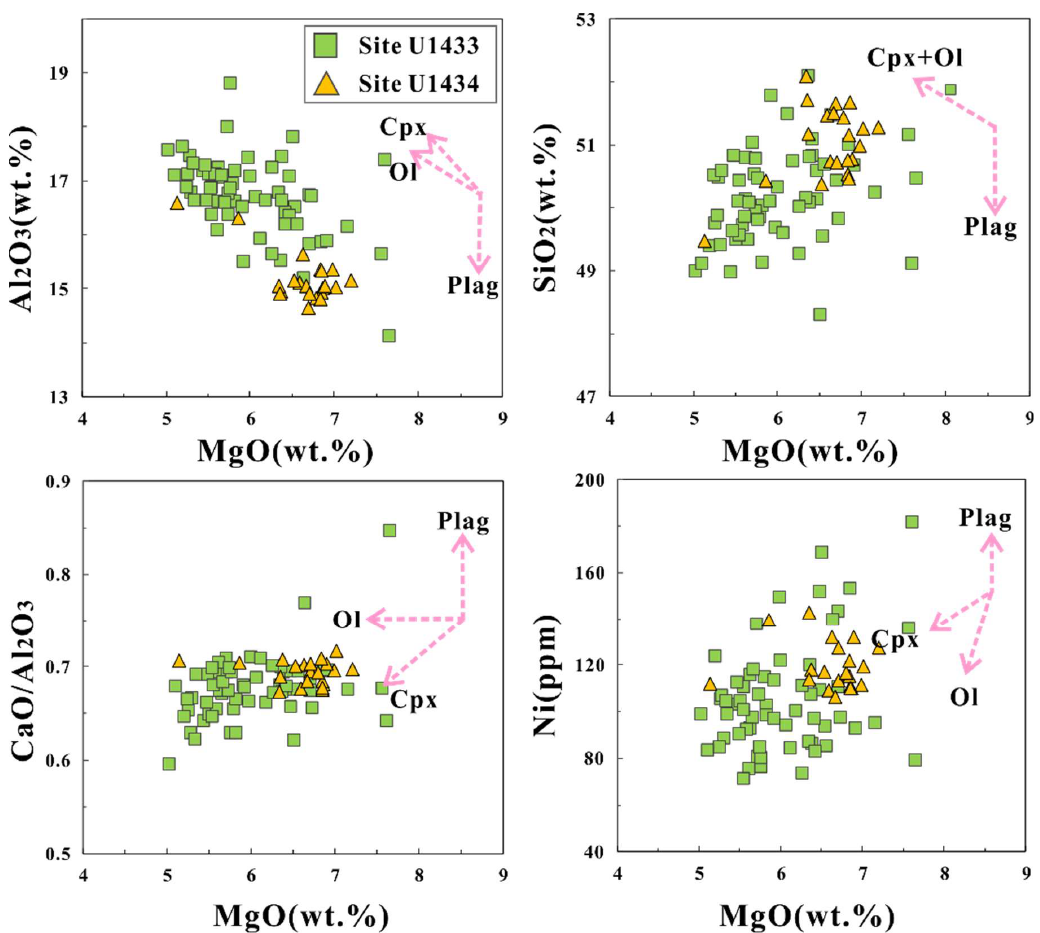
Figure 8. Variation diagrams of MgO versus selected Major (wt.%), trace elements (ppm), and element ratios for basaltic samples at Sites U1433 and U1434.